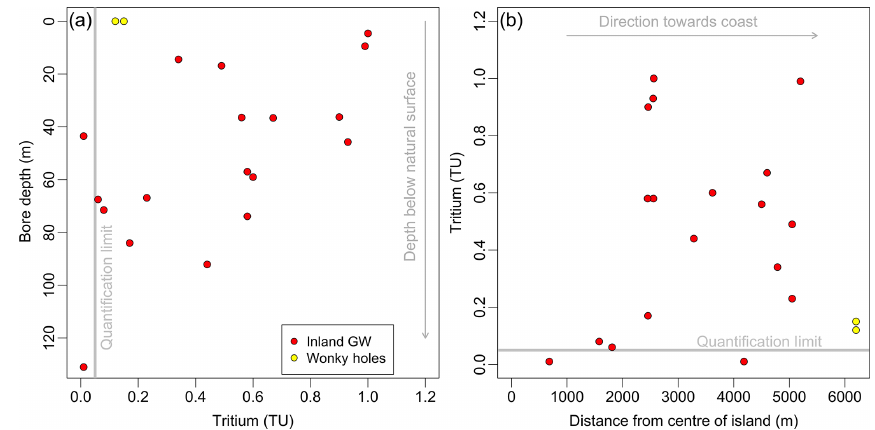
Figure 5. (a) Variation in 3 H activities with bore depth, (b) 3 H (tritium) activities vs. distance from the centre of the island, which is approximately the groundwater flow divide between westward and eastward flow.